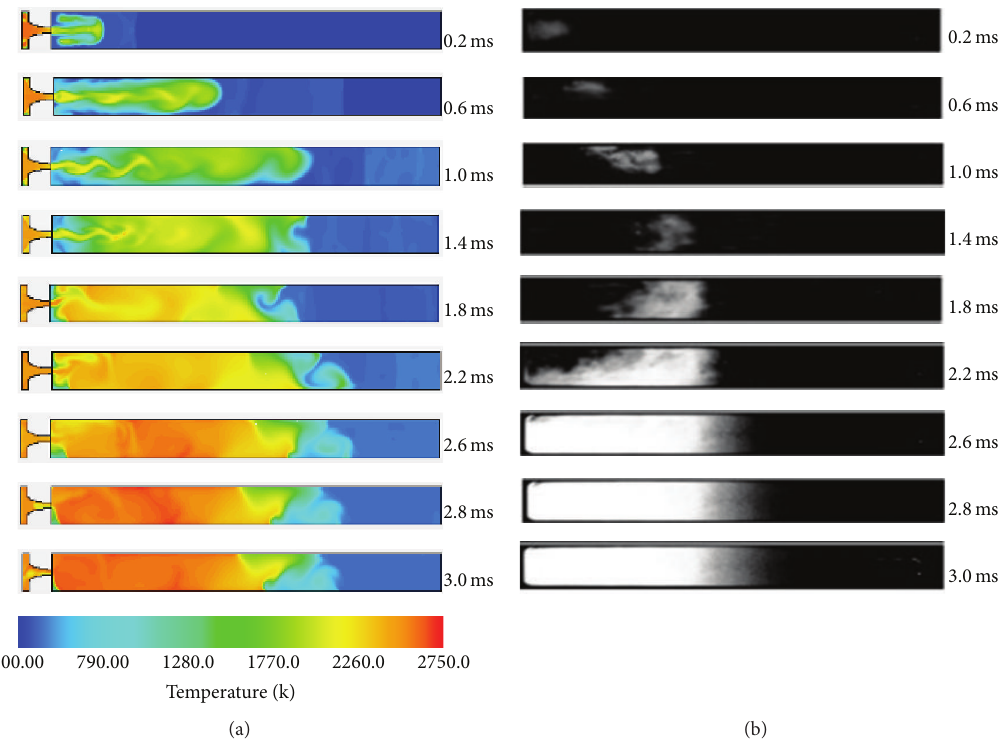
Figure 7: Combustion progress for stoichiometric methane mixture in the CVC chamber. (a) Temperature levels from simulations. (b) Flame luminosity in high-speed video images